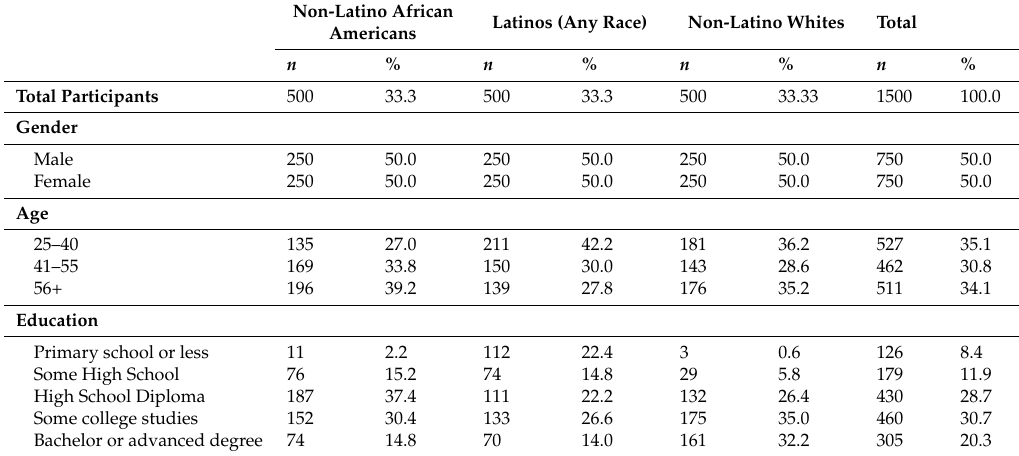
Table 2. Demographic characteristics of participants.